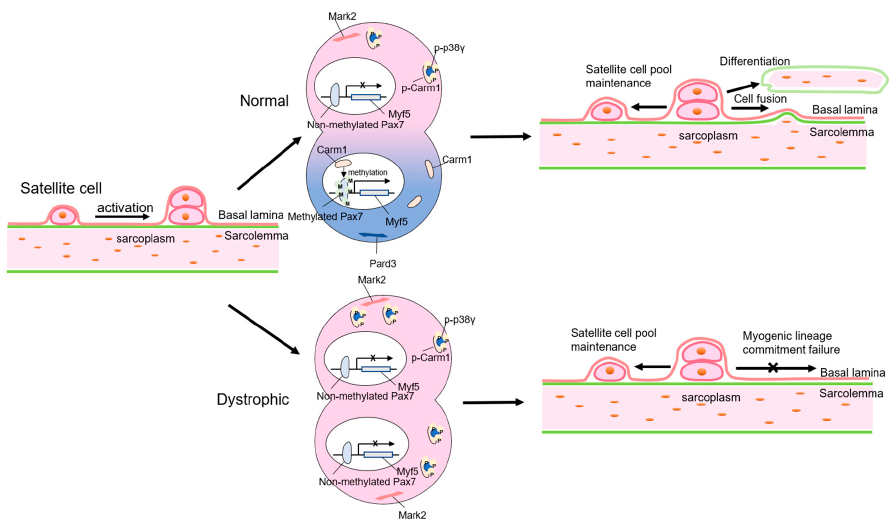
Figure 2. How intrinsic DMD gene deficit affects satellite cells (SC) activity and function. Normal SC performs asymmetric division when activated, while dystrophic SC fails to complete myogenic lineage commitment. Cell polarity regulator Mark2 is repressed in dystrophic SCs, resulting in the absence of Pard3 protein in the apical position. Carm1 in dystrophic SCs is inactivated by p38 γ , leading to Pax7 methylation deficiency and subsequent inhibition of Myf5 expression. Wild-type myogenic cells fuse with existing muscle fibers or differentiate to form new muscle fibers, whereas dystrophic satellite cells lose their differentiation capacity.